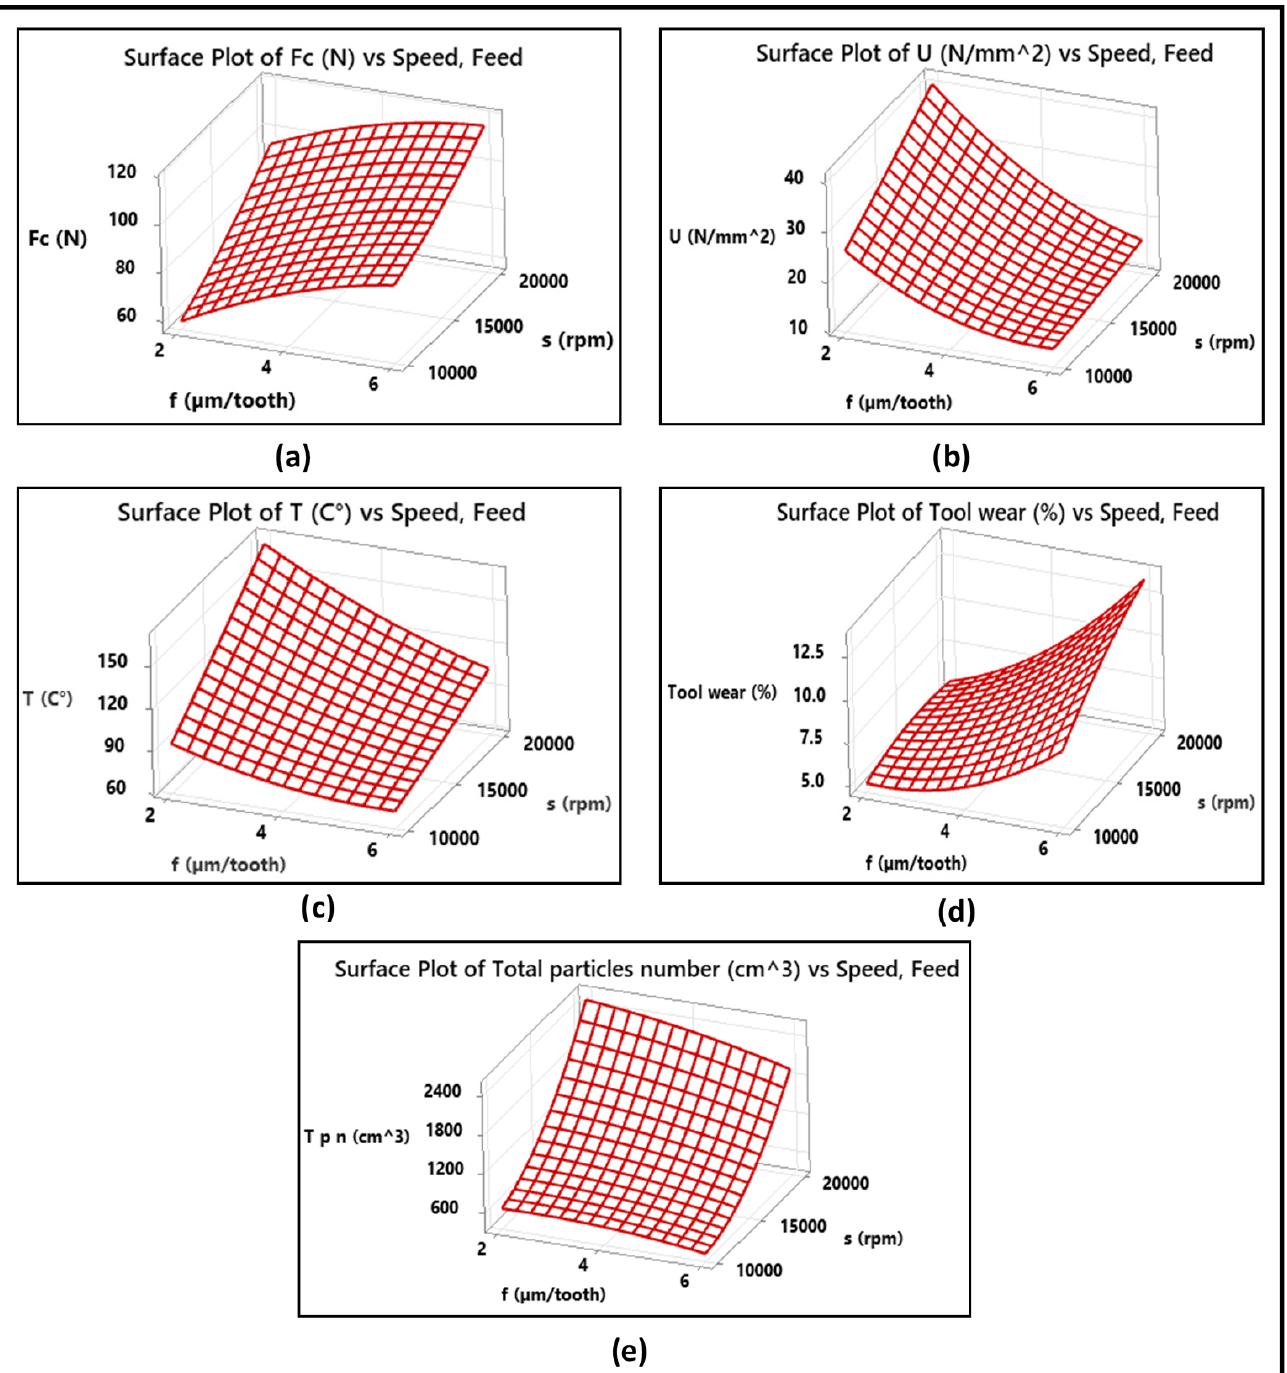
Figure 12. 3D surface plots showing effect of cutting parameters on ( a ) cutting force, ( b ) specific cutting energy, ( c ) temperature, ( d ) tool wear, and ( e ) total particles number.